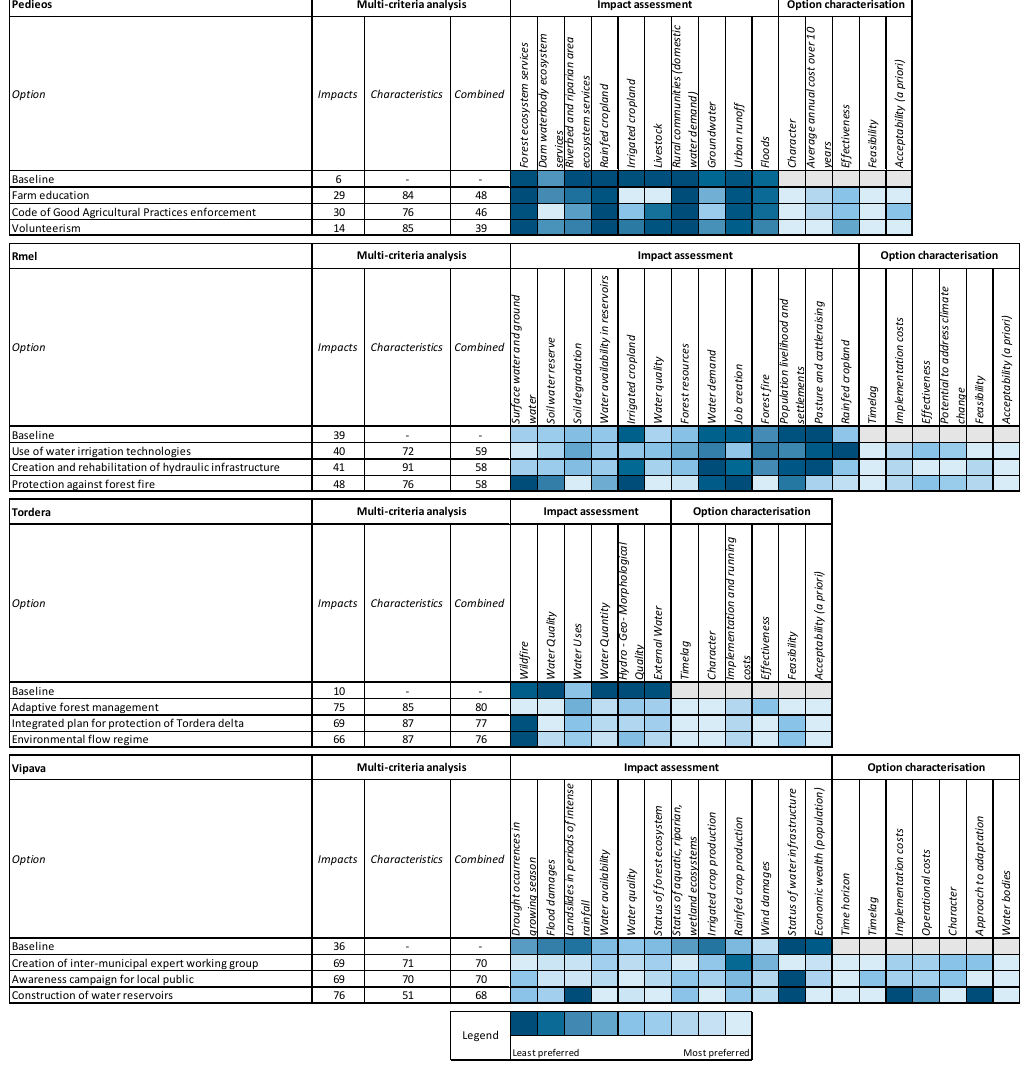
Figure 2. Illustration of the results obtained for the top three management options in the Pedieos, Rmel, Tordera and Vipava river basins. Results are shown as heatmaps in which the impacts and characterization of management options are displayed, which served as input to the multi-criteria analysis.